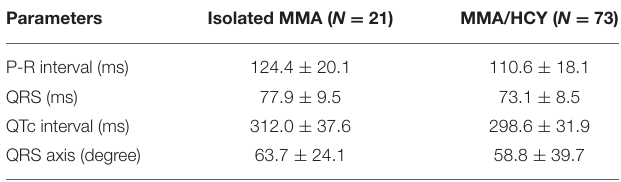
TABLE 3 | Echocardiographic variables of control, isolated MMA, and MMA/HCY groups. Echocardiographic variables